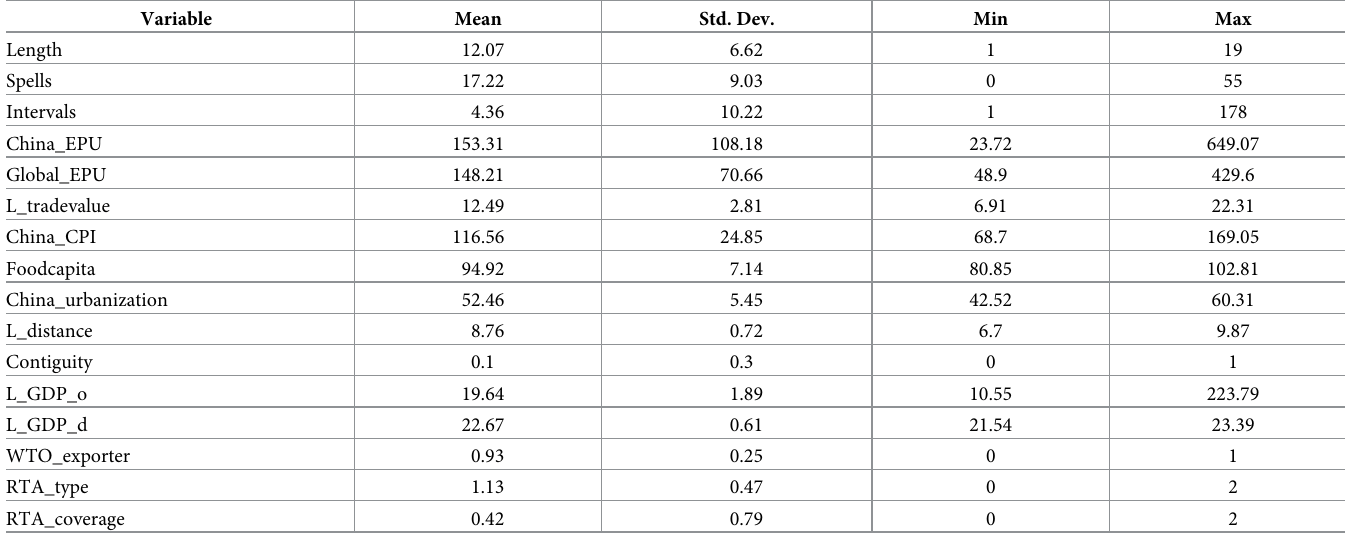
uncertainty (Global_EPU). These two indices reflect different sources of market uncertainty that alerts China’s agricultural imports. As China became the largest agricultural importer, it is important to examine whether China has an increasing market influence as well. This study applies the China_EPU and Global_EPU respectively, to distinguish and compare domestic and international influences. Table 3 presents statistic summary of the EPU indexes. Over given period, from January 2005 to July 2020, the mean of China_EPU is 153.31, while the mean of Global_EPU is 148.21. The China_EPU has always been higher than Global_EPU over the given period, and the maximum of China_EPU (649.07) is more than 50% larger than that of Global_EPU (429.46). Standard deviation of China_EPU is larger than that of Globa- l_EPU as well, indicating that China_EPU has a higher volatility. Substantial volatility of EPU Table 3. Statistics summary of determinants on agri-food imports.